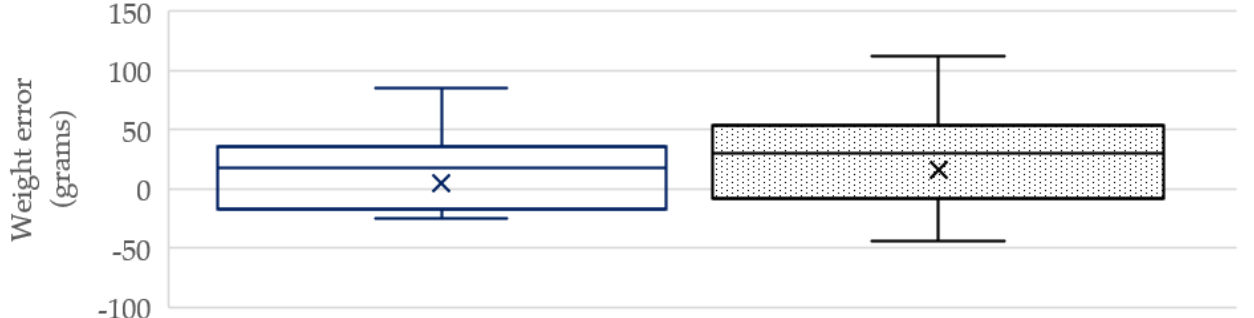
Figure 17. Comparison of the distribution of actual weight and estimated weight by proposed TWE-DRL method.